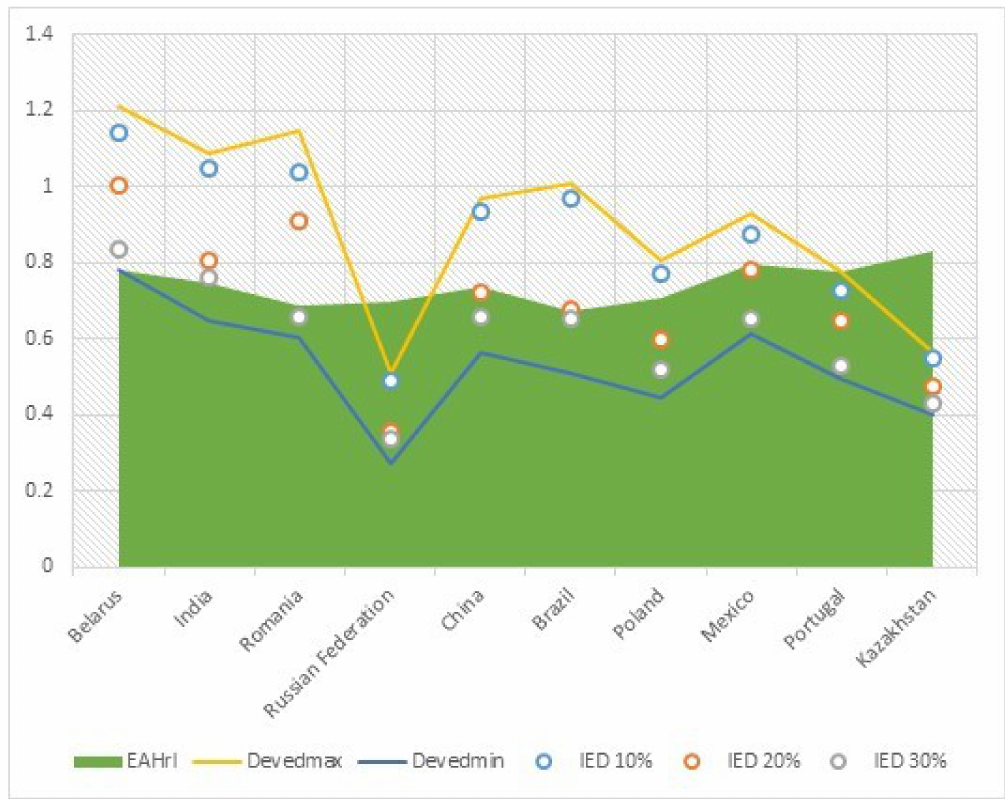
Figure 5. Forecast indicators of the impact of households’ energy autonomy on the level of energy dependence of the studied developing countries until 2030. Source: generated by the